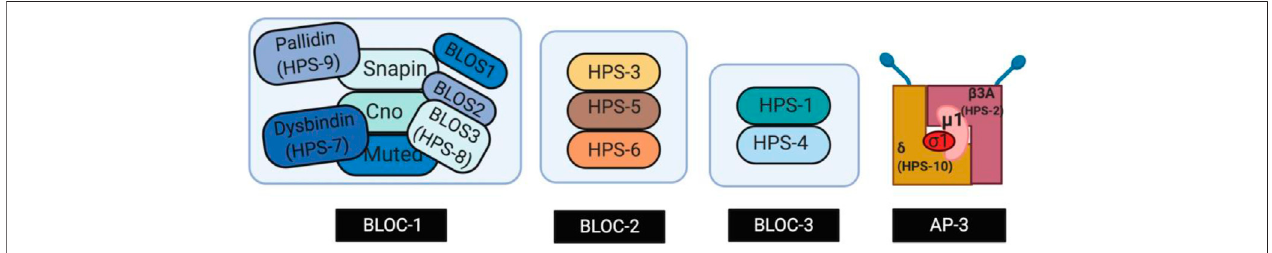
FIGURE1| Genesencoding subunits offour proteins complexescalled the Biogenesis ofLysosome-related Organelles Complexes (BLOC-1,-2, -3)and Adaptor Protein-3 (AP-3). The protein complexes play a role in the intracellular traf fi cking required for LRO biogenesis. Created with BioRender.com.